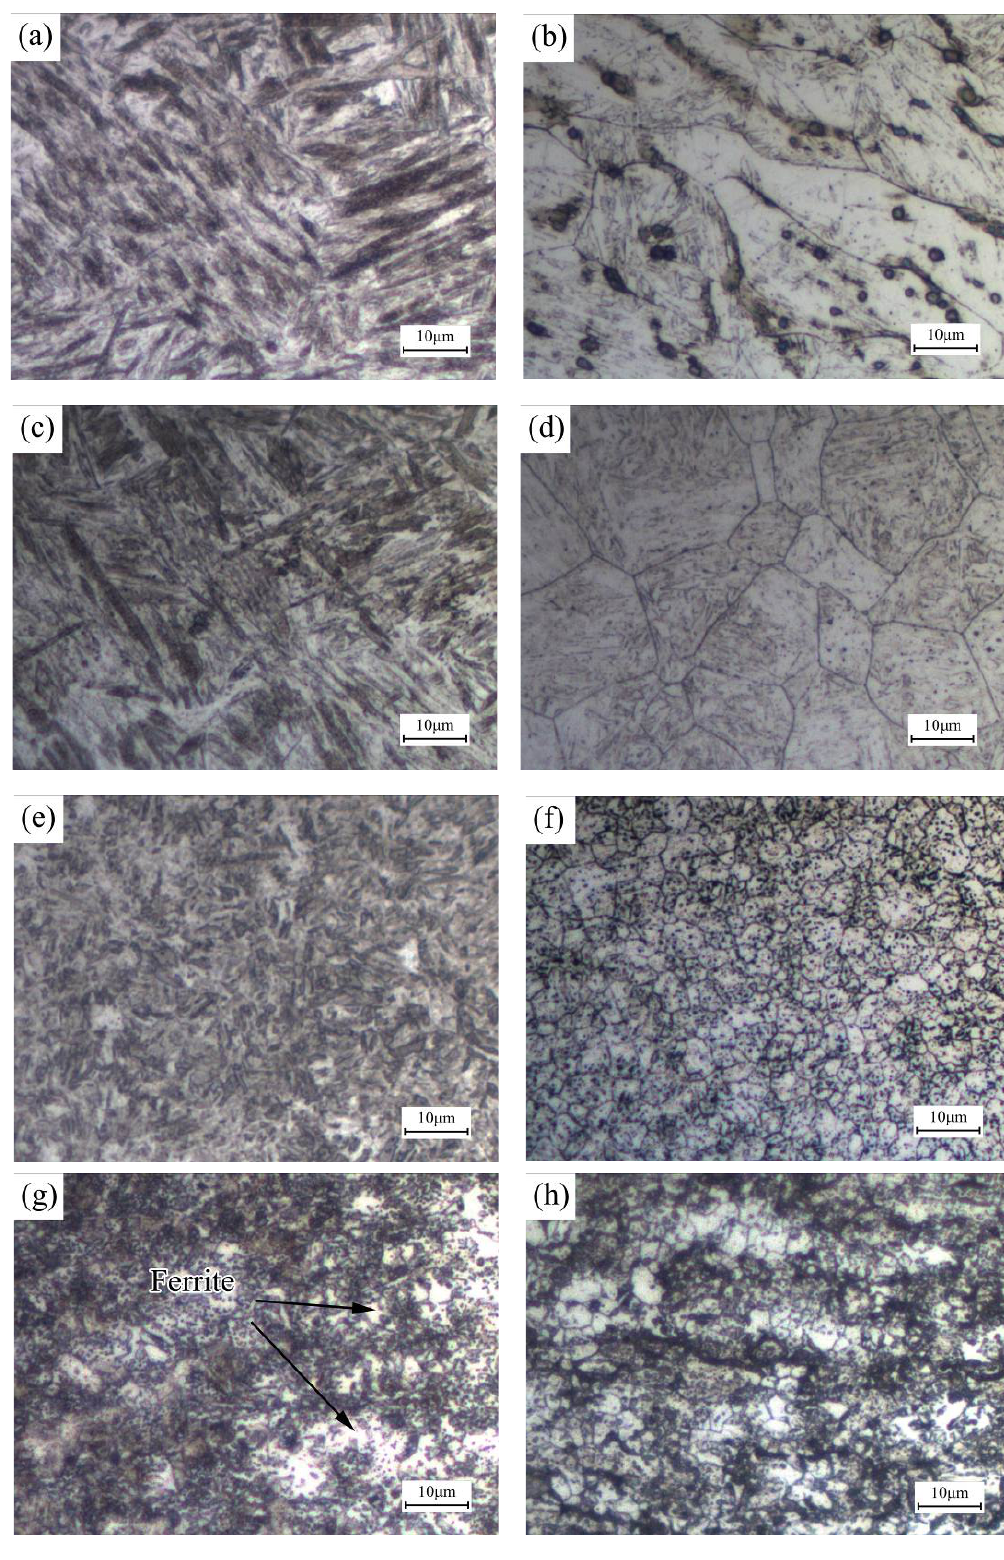
Figure 7. Metallographic structure of ( a ) FZ; ( c ) CGZ; ( e ) FGZ; ( g ) IRZ, and grain morphology of ( b ) FZ; ( d ) CGZ; ( f ) FGZ; ( h ) IRZ of weld joint welded under 30 mm/s.